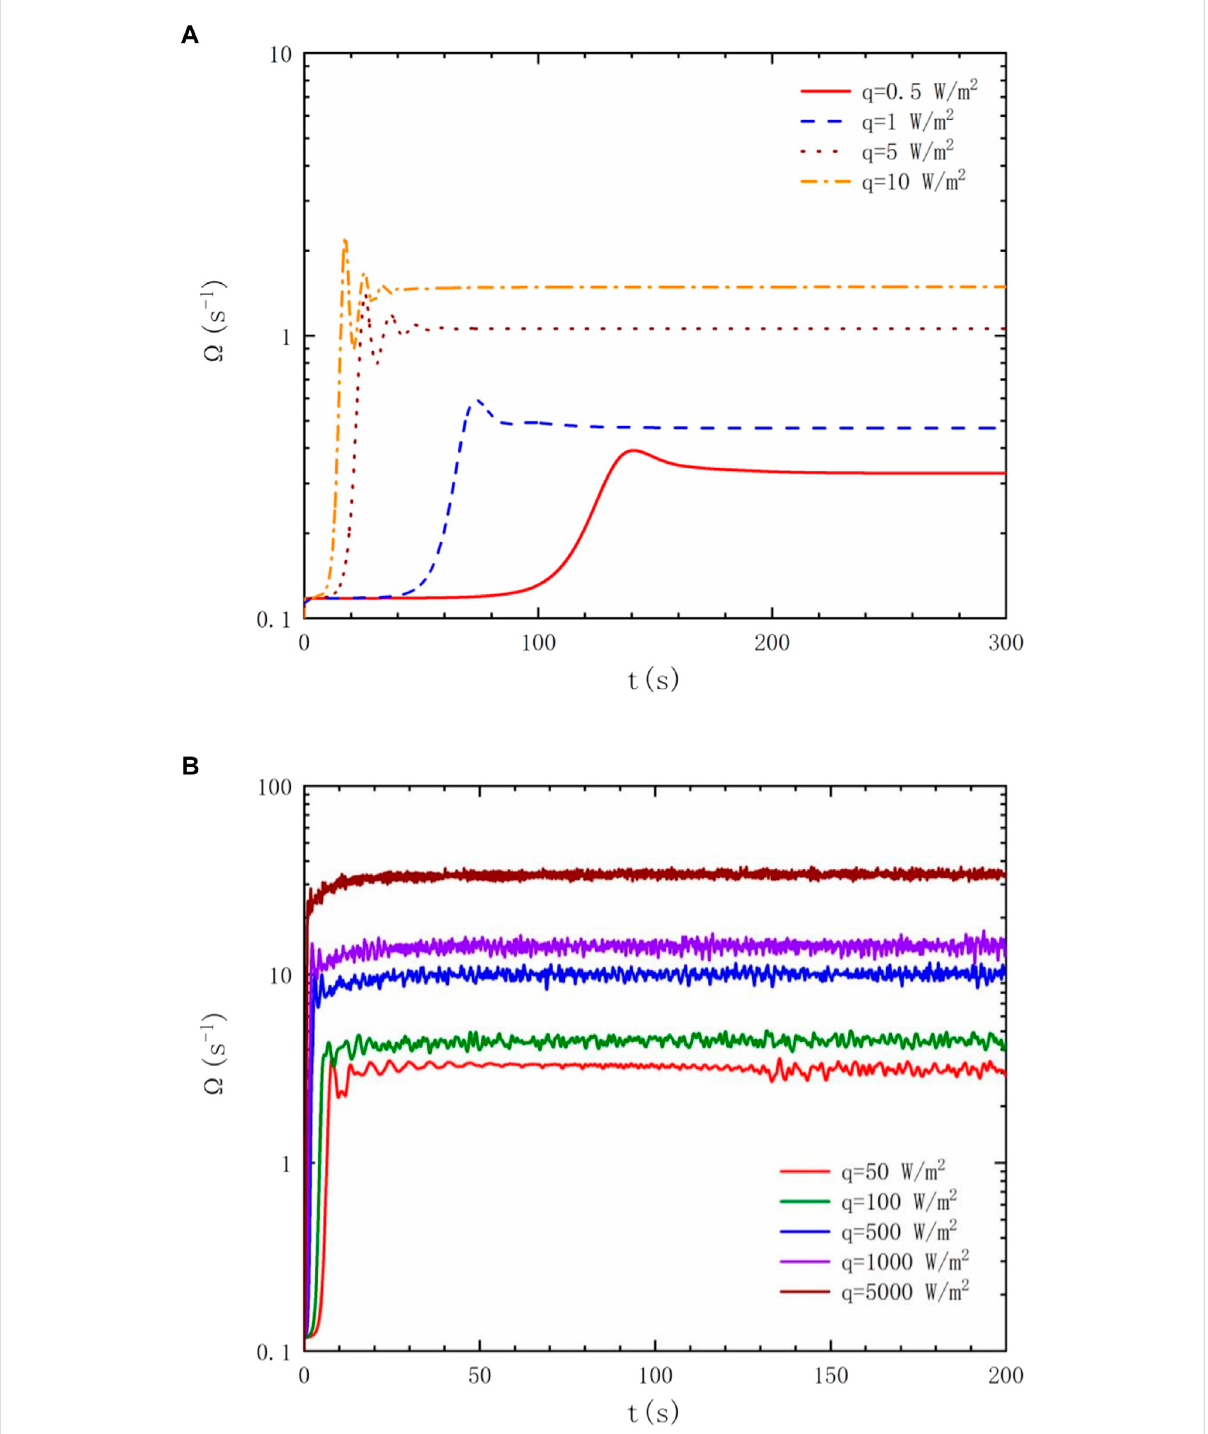
FIGURE 5 Space-averaged vorticity Ω as the time evolution with different heat fl uxes. (A) low heat fl uxes (q ≤ 10 W/m 2 ); (B) high heat fl uxes (q ≥ 50 W/m 2